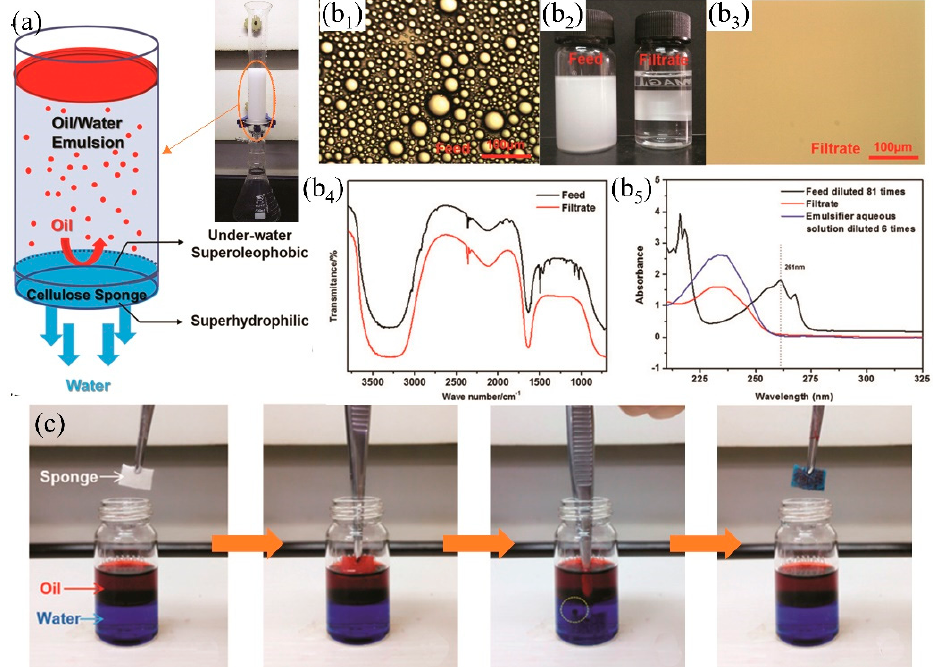
Figure 14. ( a ) Schematic diagram of the cellulose sponge separates oil/water (toluene ‐ in water emulsion), ( b ) the emulsion separation result: ( b 2 ) comparison of the emulsion before (left) and after (right) filtration, photograph ( b 1 ) and ( b 3 ), FTIR ( b 4 ) and UV-VIS ( b 5 ) of emulsion before and after filtration, ( c ) self-cleaning and resistance to oil pollution of cellulose sponge [89]. reproduced with permission from Royal Society of Chemistry.